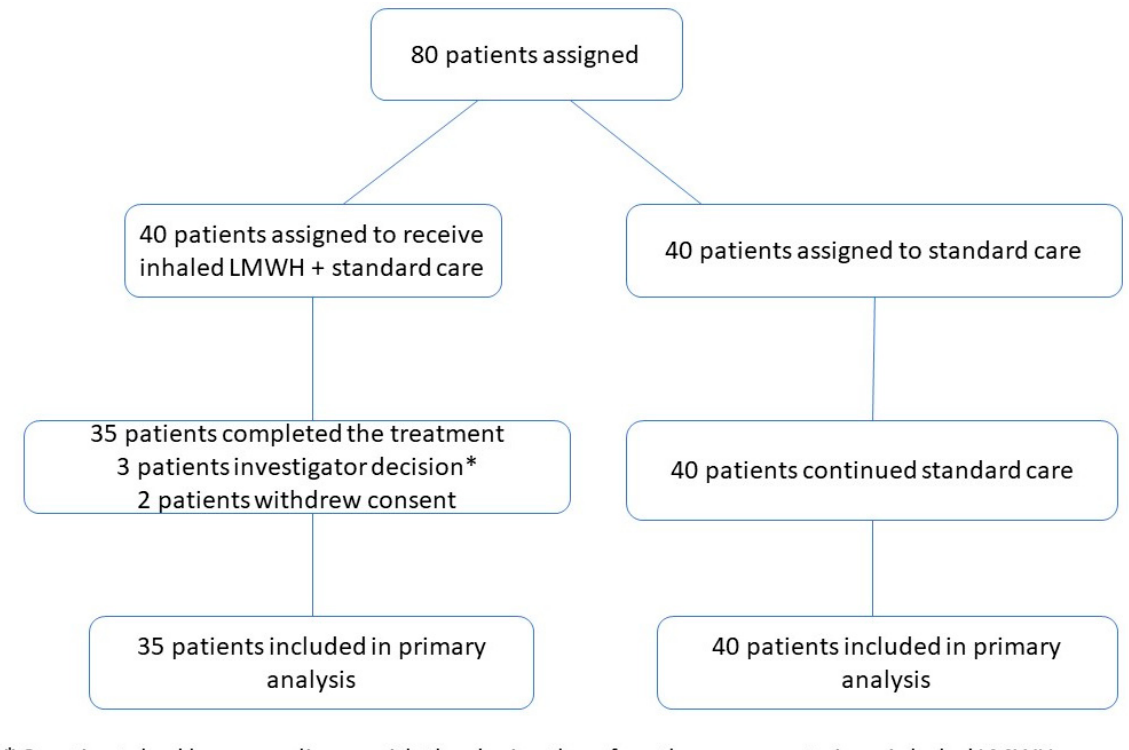
Figure 2. Participant Flow Chart.